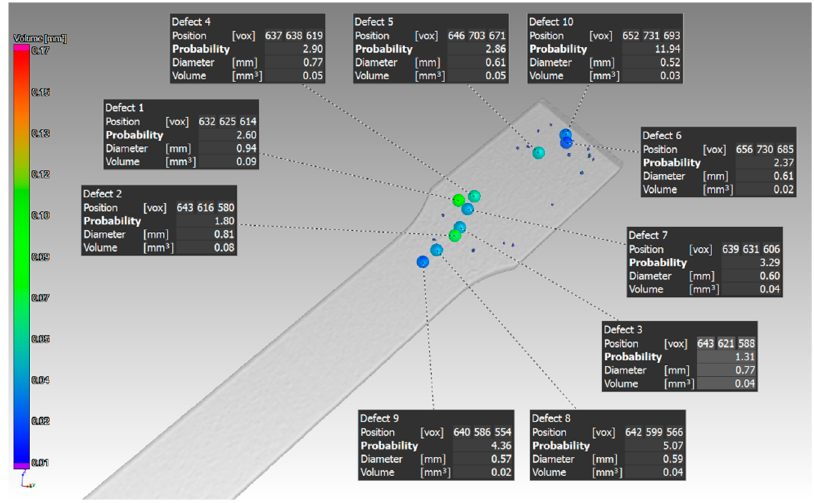
Figure 6. The biggest defects in the sample, which had a thickness of 1 mm and was oriented in Z. Figure 7 shows the statistics of evaluated values of material volume, defect volume, and defect volume ratio for a sample, which had a thickness of 1 mm and was Z oriented.